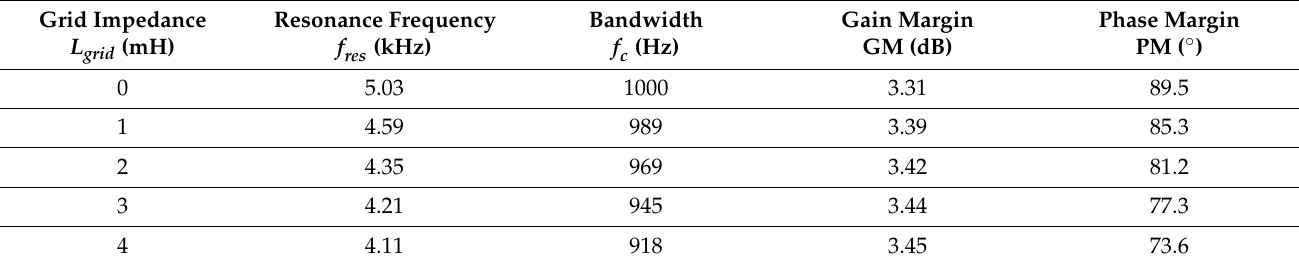
Figure 12. Loop gain Bode plots for LCL filter type GcI with FESO-based ADRC ( a ) Under observer bandwidth variation; ( b ) Under grid impedance variation. Table 5. Stability Analysis of FESO Based ADRC for the LCL Filter Type GcI.